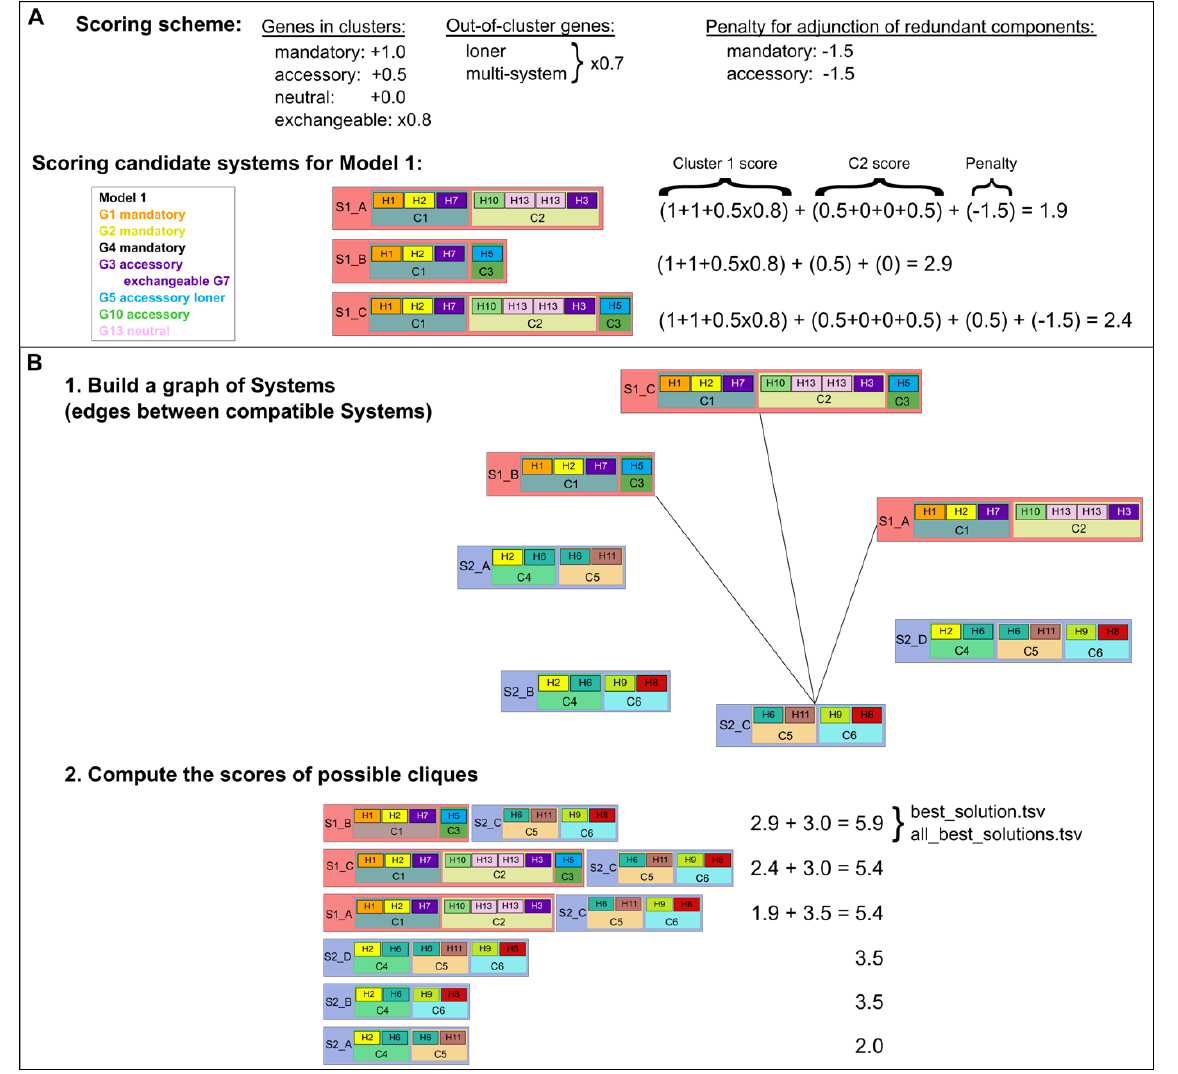
Figure 2 - Scoring scheme and combinatorial search of MacSyFinder v2 search engine. A. The scoring scheme is summarized, and then illustrated by an example for a hypothetical Model1. “H1” stands for a hit for gene 1 “G1” in the genome. B. Step (1). The graph of candidate systems is drawn by connecting all compatible systems, i.e. those with non-overlapping hits (unless authorized by the multi-model or multi-system feature). Step (2). The clique of maximal cumulated score (best solution) is searched, with the score being defined as the sum of the systems’ scores that are part of the clique. The results are stored in the files “best_solution.tsv” and “all_best_solutions.tsv”, and all candidate systems are stored in